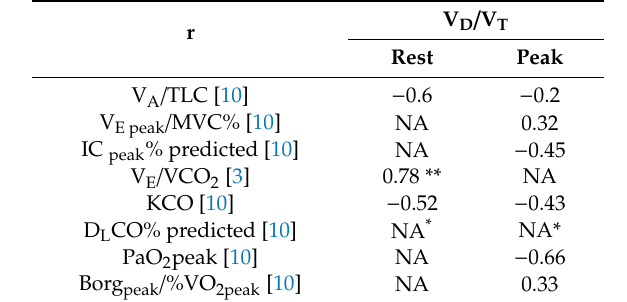
Table A1. Summary of the correlation coe ffi cient (r) between the dead space fraction (V D / V T ) and some physiological variables reported by Mahut et al. [10] and Elbehairy et al. [3].